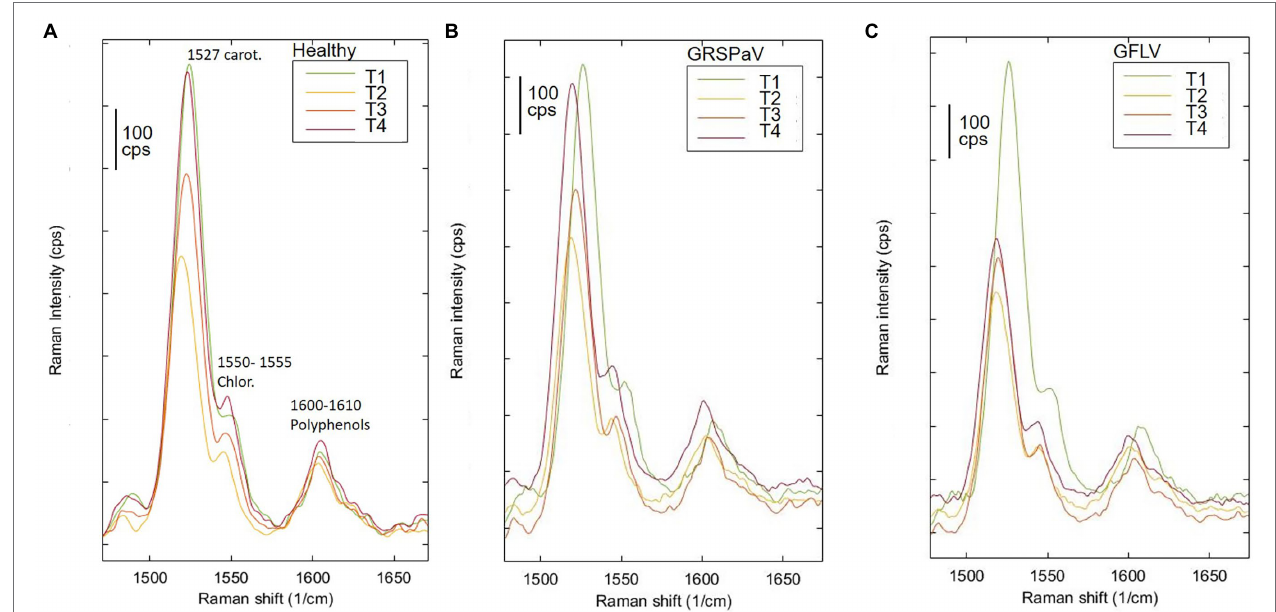
FIGURE 3 | Raman spectroscopic analysis of (A) healthy and of (B) GRSPaV- or (C) GFLV-infected grapevine cv. Chardonnay leaves, at different time points (T1 to T4) during the vegetative season. Focus on the peaks associated to carotenoids and chlorophyll. Average spectra are the result of four plants per